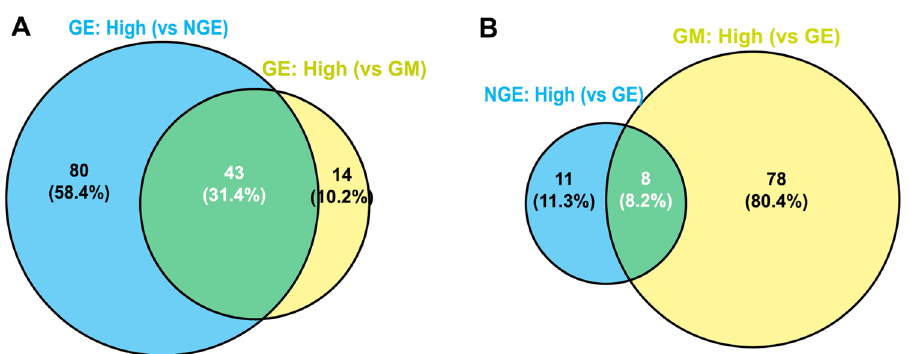
Figure 4. Venn diagram illustrating the number of distinct and overlapping DEGs in the GE compared to NGE and GM of the base of oral cavity. ( A ) Highly expressed DEGs in the GE compared with NGE (blue) and GM (yellow). ( B ) Highly expressed DEGs in the NGE and GM compared with GE. Statistically significant genes ( p < 0.05) with a fold change > 1.5 were included. GE: gustatory epithelium; NGE: non-gustatory epithelium; GM: gustatory